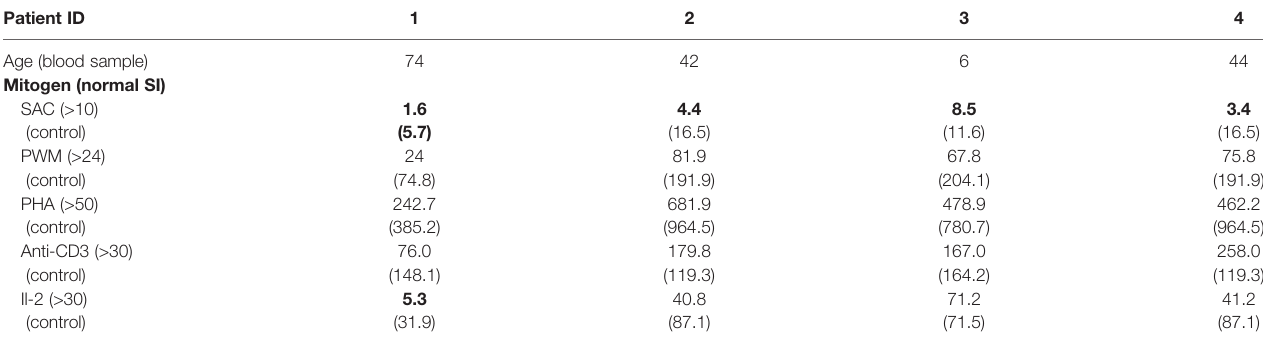
TABLE 2 | Lymphocyte proliferative response upon stimulation with mitogens. Patient